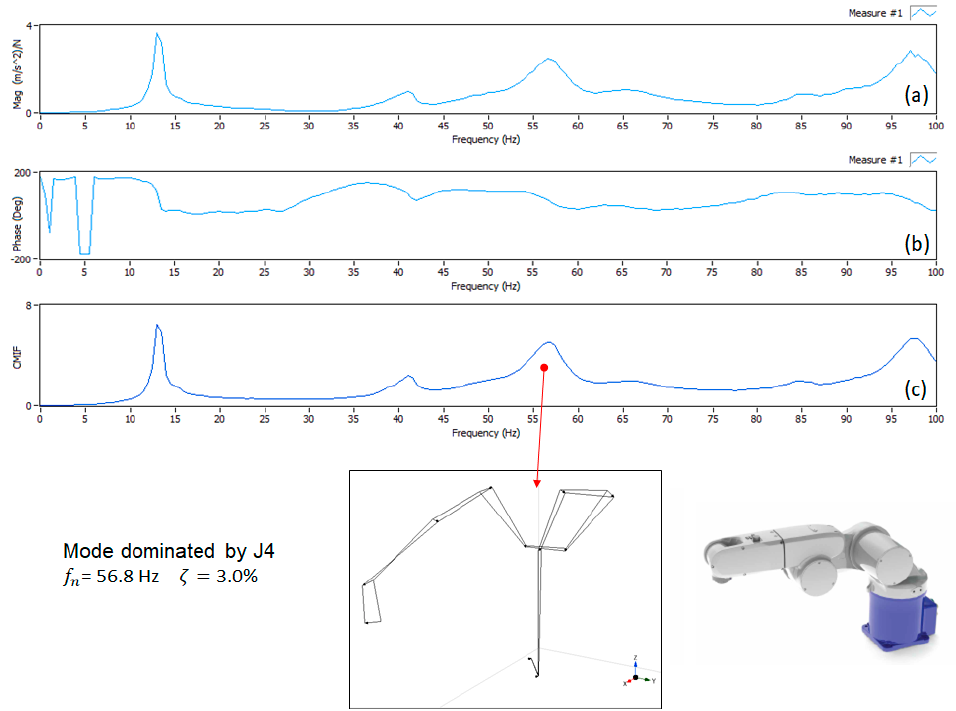
Figure 10. Test 4, ( a ) direct point frequency response function (FRF) modulus, ( b ) phase, ( c ) complex mode indicator function (CMIF).